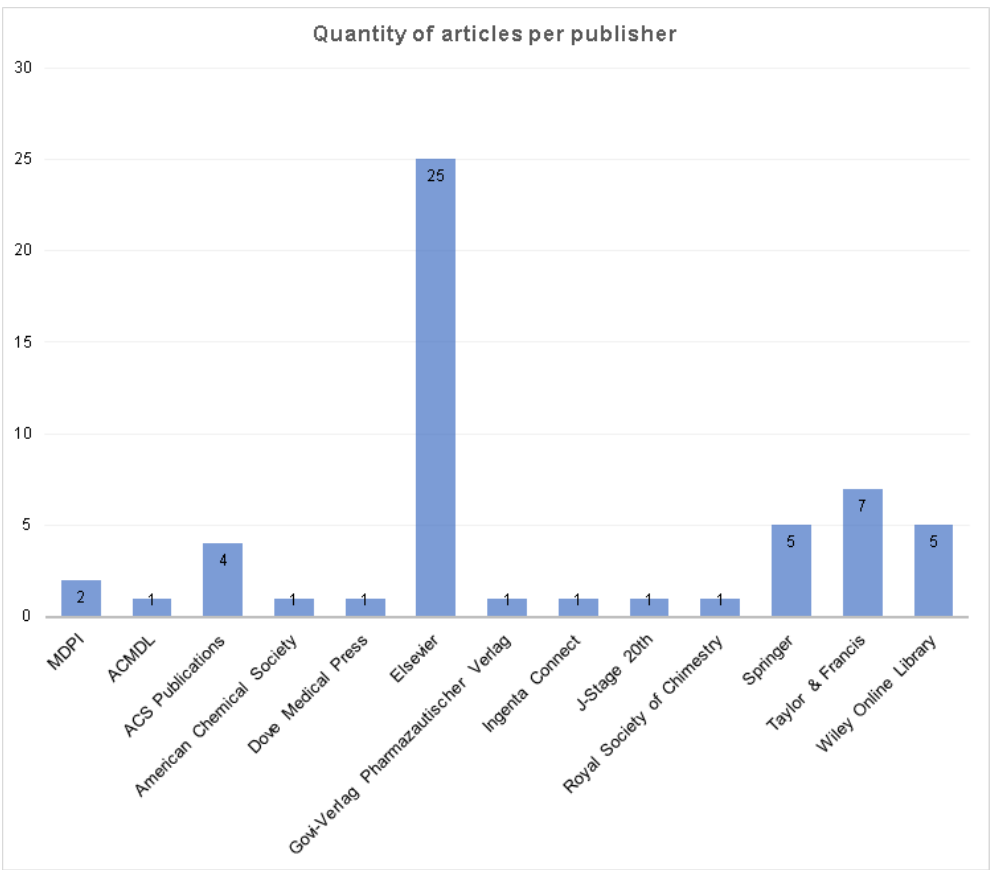
Figure 4. Amount of articles per publisher, considering the sample.